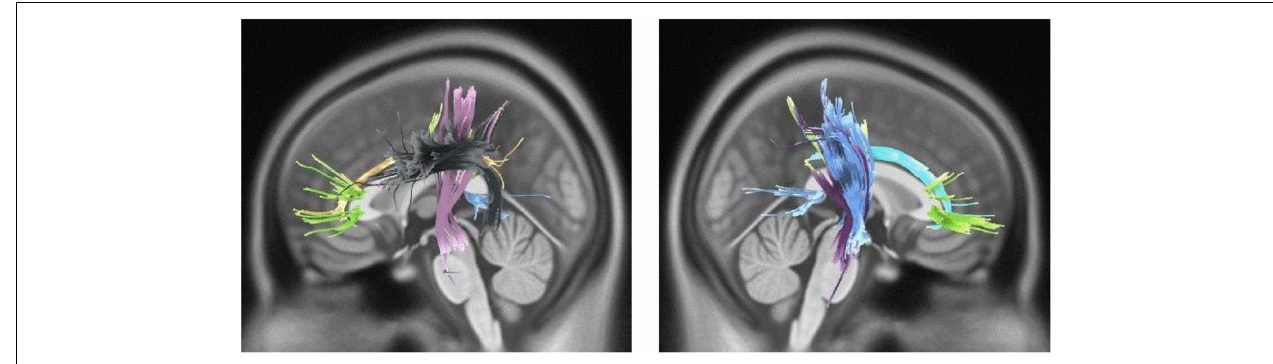
FIGURE 3 | White matter pathways with marginally significantly positive association with musical training in male participants (FDR = 0.057).